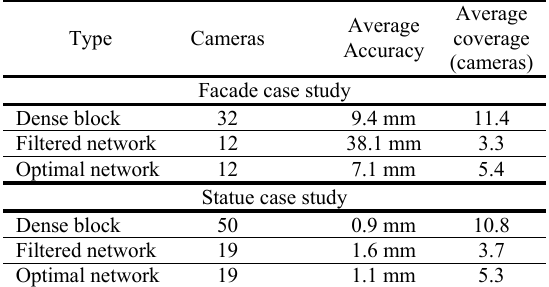
Table 1. Summary of